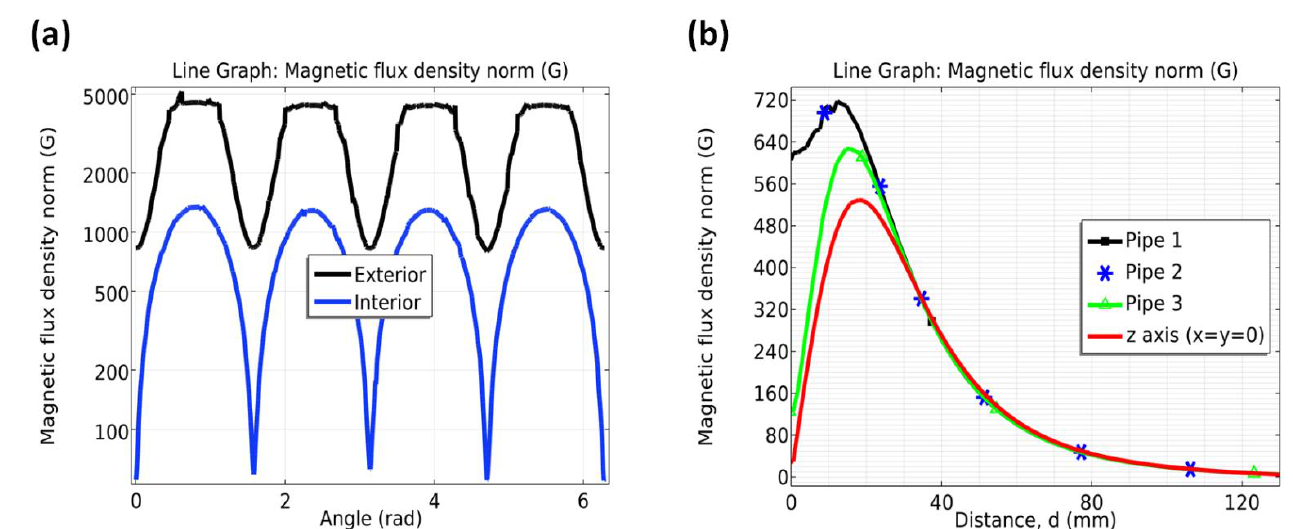
Figure 3. ( a ) Magnetic field strength around an outer circumference of a radius such that it is tangent to each of the inner sides of the magnets (black) and SMF strength around a circumference of an inner radius that is 65% of the outer radius and intersects the pipes (blue). ( b ) SMF strength gradient along the symmetry axis of the experimental pipes and SMF strength along the symmetry axis of the three pipes.